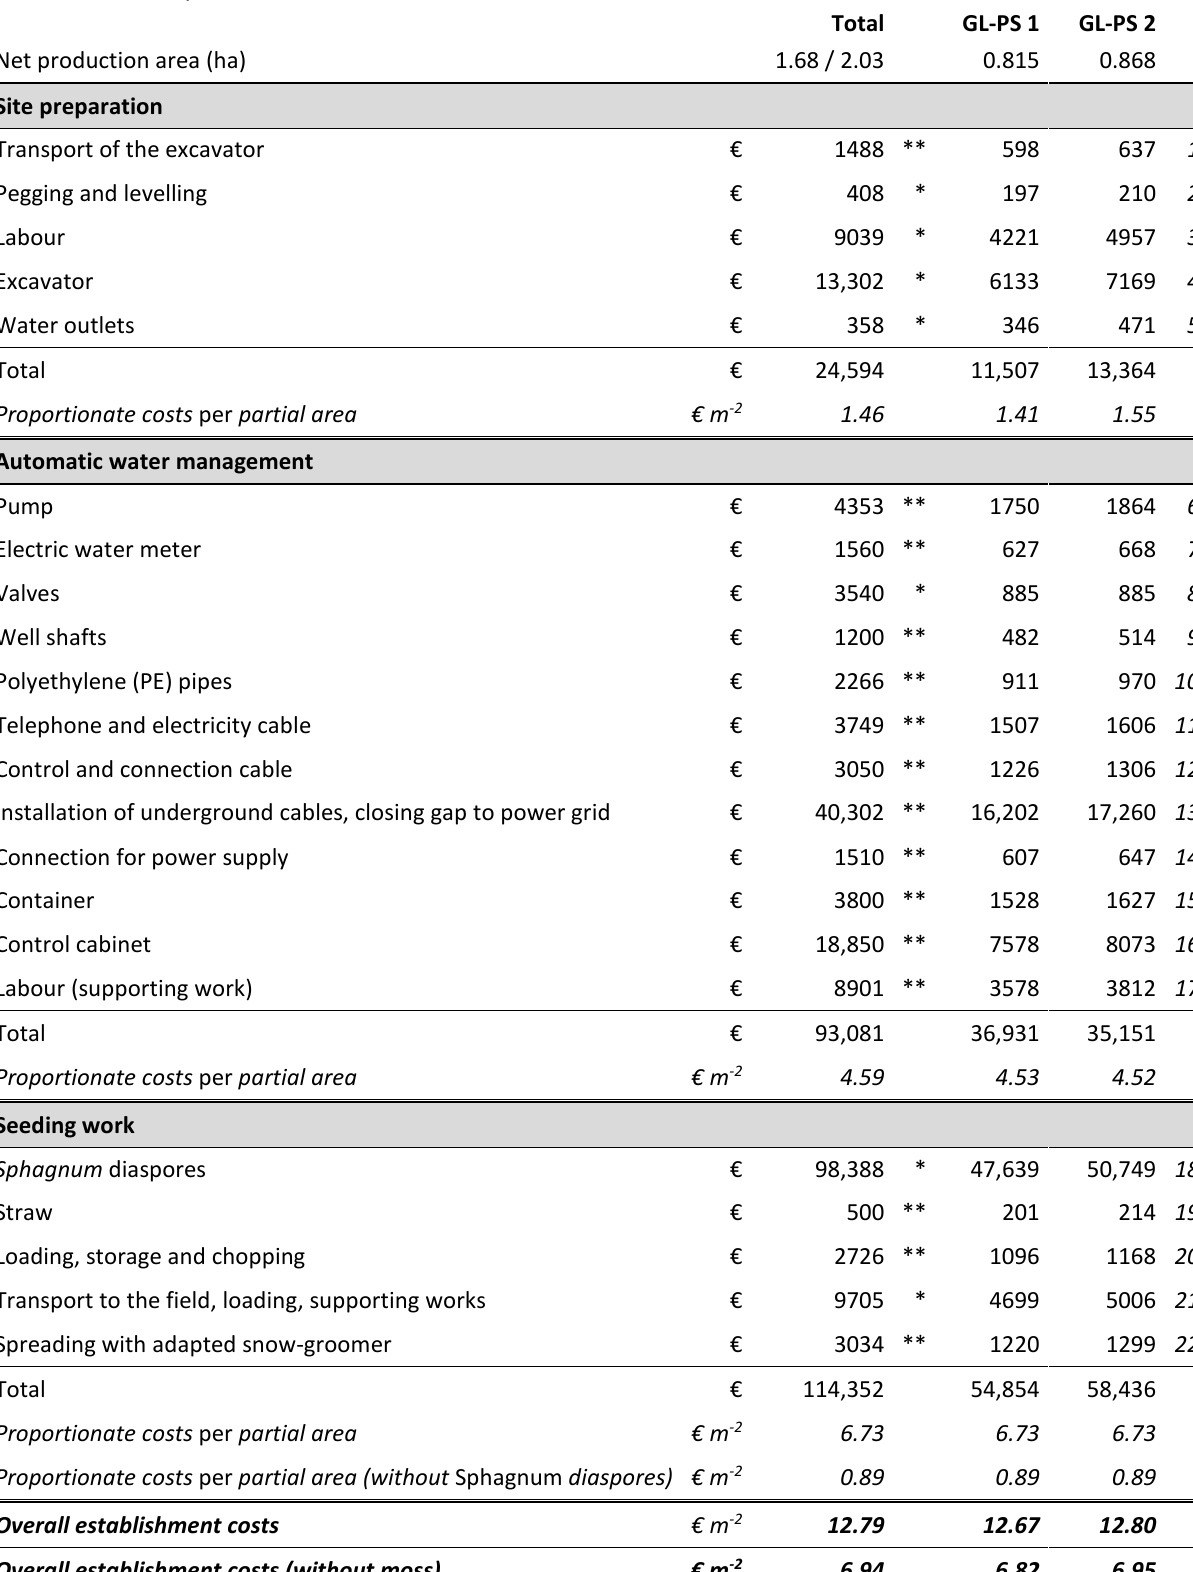
Table 3. Labour, machinery and investment costs of establishing Sphagnum cultures on bog grassland in Rastede (Lower Saxony, Germany) in 2011. In order to calculate proportionate costs, some cost items (*) had to be related only to GL-PS 1 and GL-PS 2 (total: ~ 1.68 ha), while others (**) applied to the whole pilot area (2.03 ha net production